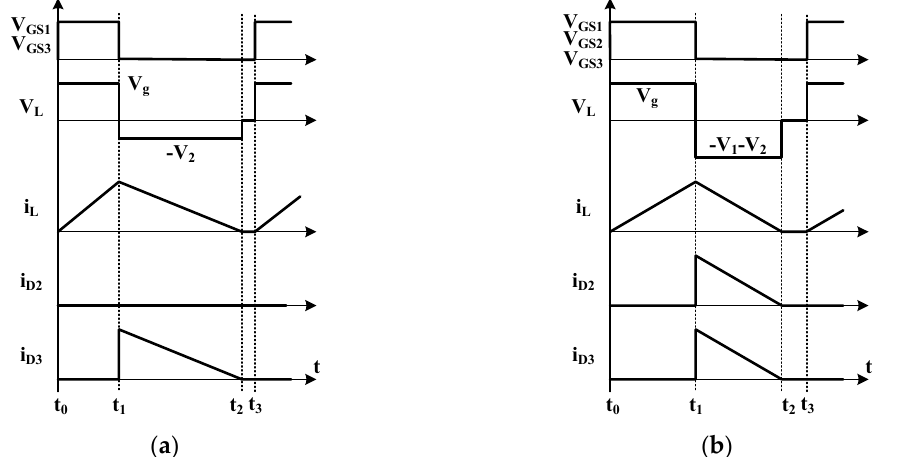
Figure 5. Step-up / down operation relative waveforms of ( a ) single-battery charging, ( b ) dual-battery charging with the same current.